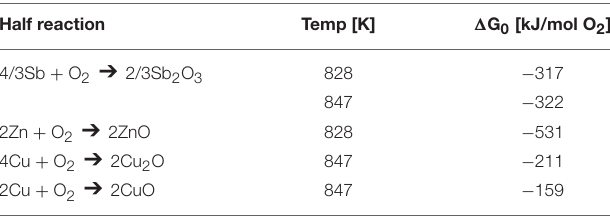
TABLE 3 | Free energies for the reaction of Sb 2 O 3 with Zn and Cu at 555 and 574 ◦ C, respectively, according to Equation (2).